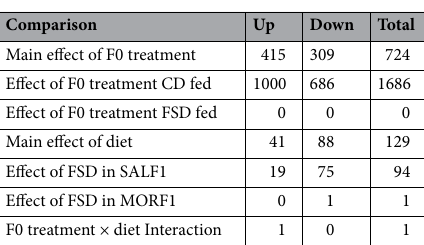
Gene sets enriched in FSD SALF1 males as compared to CD SALF1 males, also implicate enhanced transcrip- tional activity and diminished cellular respiration, although these effects are more muted than the effects of F0